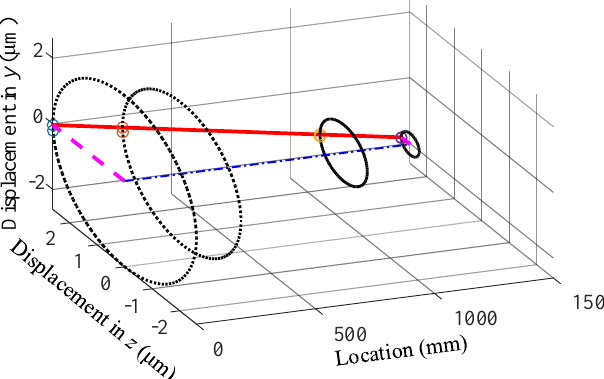
Figure 6. Response of high-pressure rotor at low speed. ( a ) time domain response; ( b ) frequency domain response.